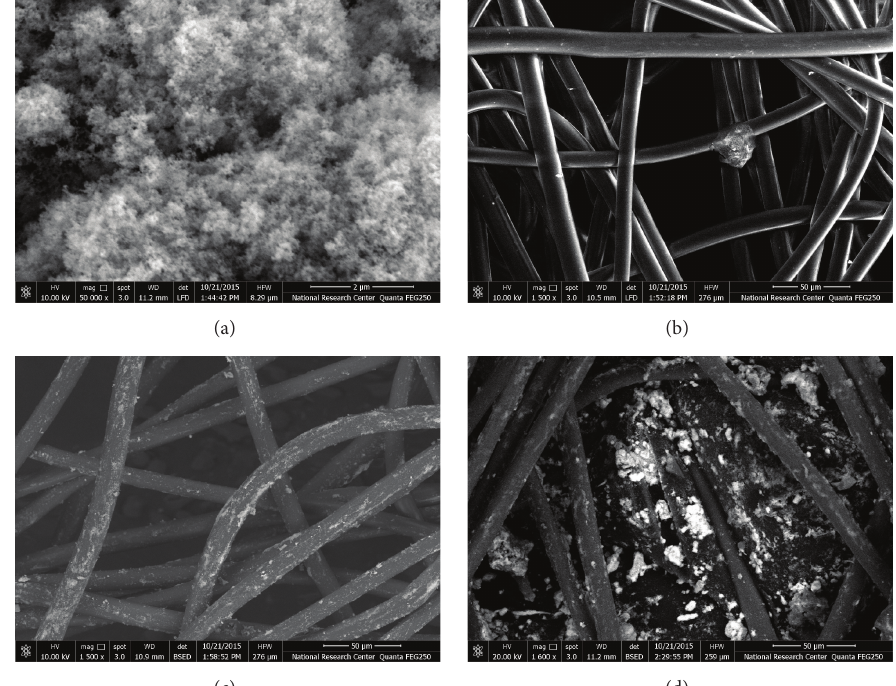
Figure 4: SEM images of (a) TiO 2 , (b) pristine PET, (c) TiO 2 coated PET, and (d) solar irradiated TiO 2 coated PET. Bars in (a) and (b)–(d) = 2 𝜇 m and 50 𝜇 m, respectively.